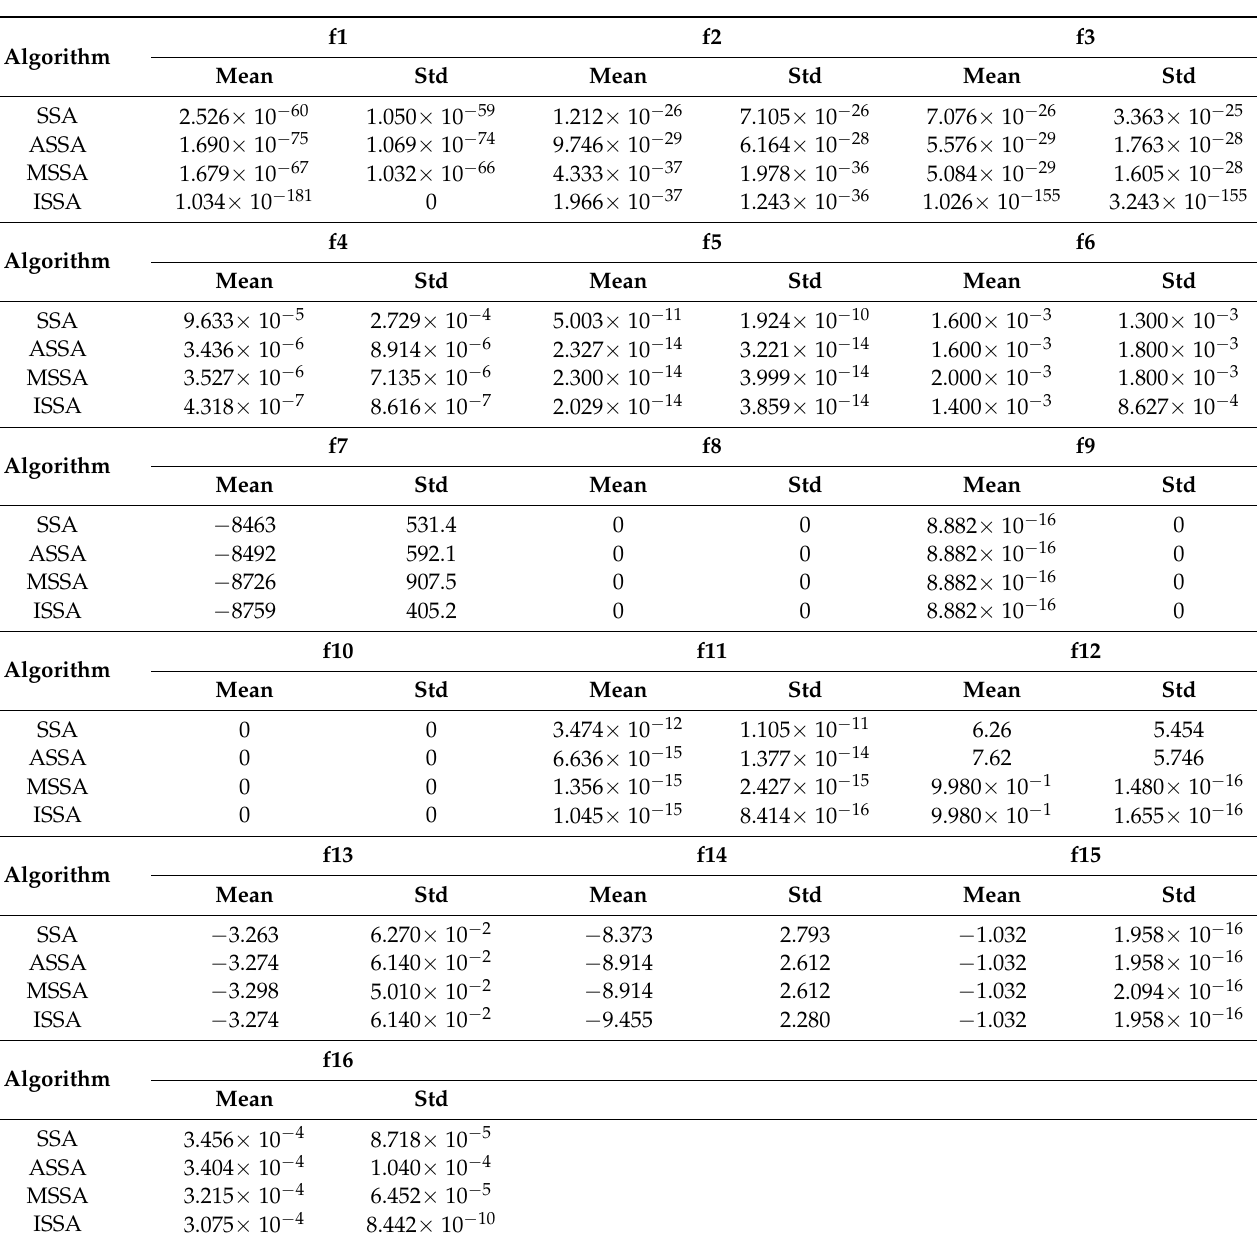
Table 5. Experimental results of model